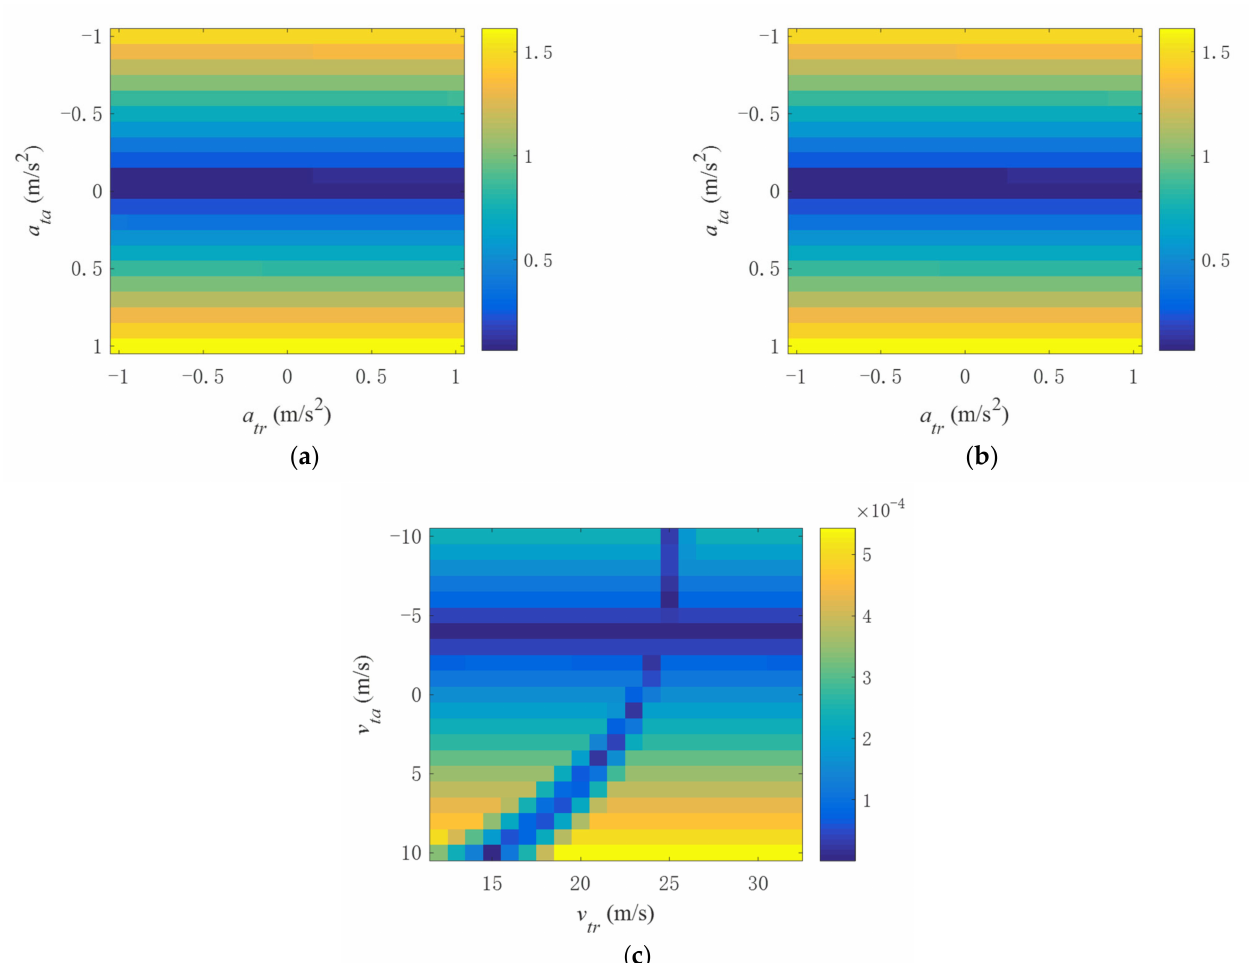
Figure 4. Dependency between the phase error and a ta and a tr . ( a ) The reference channel, ( b ) the 2th channel, and ( c ) the difference between phase error in the reference channel and the 2th channel. The target’s velocities are set to be: v ta = − 10 m/s, v tr = 12 m/s. In the figures, the color indicates the value of the phase error, and the unit is